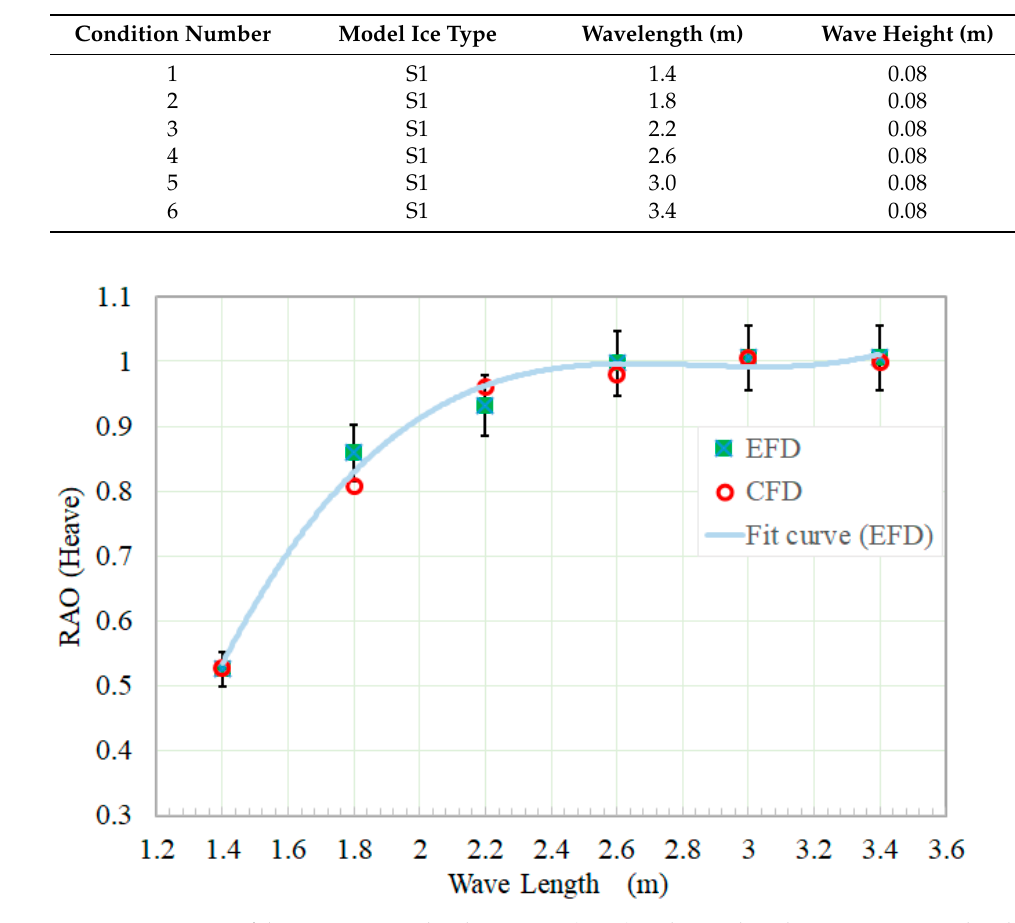
Figure 8. Variation of the response amplitude operator (RAO) with wavelength at constant wave height. The motion of ice floes along the x, y, and z directions with a fixed wave height and varied wavelength is shown in Figure 9. The wave heights are all at 0.08 m and the wavelengths at these heights are 1.4, 1.8, 2.2, 2.6, 3.0, and 3.4 m, respectively. Under the action of waves, the ice floe moves forward continuously. The motion in the x direction is divided into two parts: oscillating surge and drift motions. Drift motion is mainly caused by the second-order drift force of waves. Figure 9a shows the drift motion along the x direction. From Figure 9a, it can be observed that the drift displacement along the x-axis is closely related to the wavelength. The wavelengths in numerical simulation are larger than the characteristic length of ice floe. The trajectory of the floating ice drifting along the x-axis is in a periodic reciprocating motion, and it gradually moves away from the initial position along the positive direction of the x-axis. Figure 9b shows the time history curve of ice floe rotating along the y-axis, and Figure 9c presents the time history curve of ice floe translation along the z-axis. Both the rotational and translational motions along the y- and z-axes, respectively, are periodic. It can be observed from Figure 9b that when the wavelength is small, the rotation amplitude along the y-axis is large, and with the increase in the wavelength, the rotation amplitude along the y-axis decreases. Figure 9c shows that the translational reciprocating motion along the z-axis is steady when the wavelength is small but intensified when the wavelength is